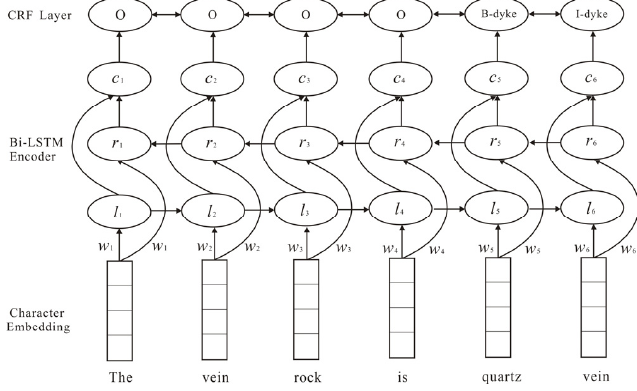
Figure 2. The neural network architectures of Bi-LSTM and CRF [48].